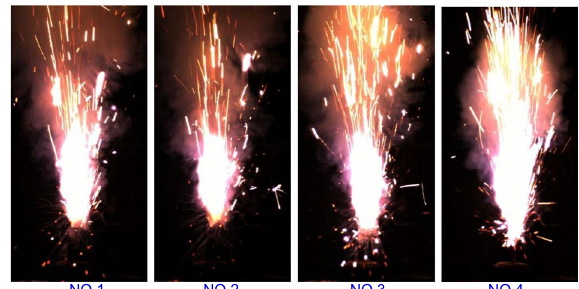
Figure 4. Combustion of the pyrotechnic composition.